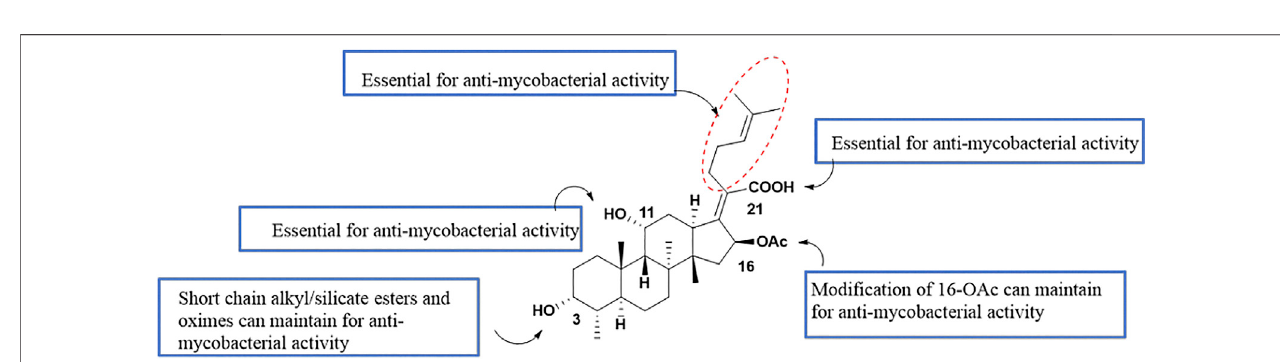
FIGURE 4 | Structural formulae of compounds 13 – 17 .